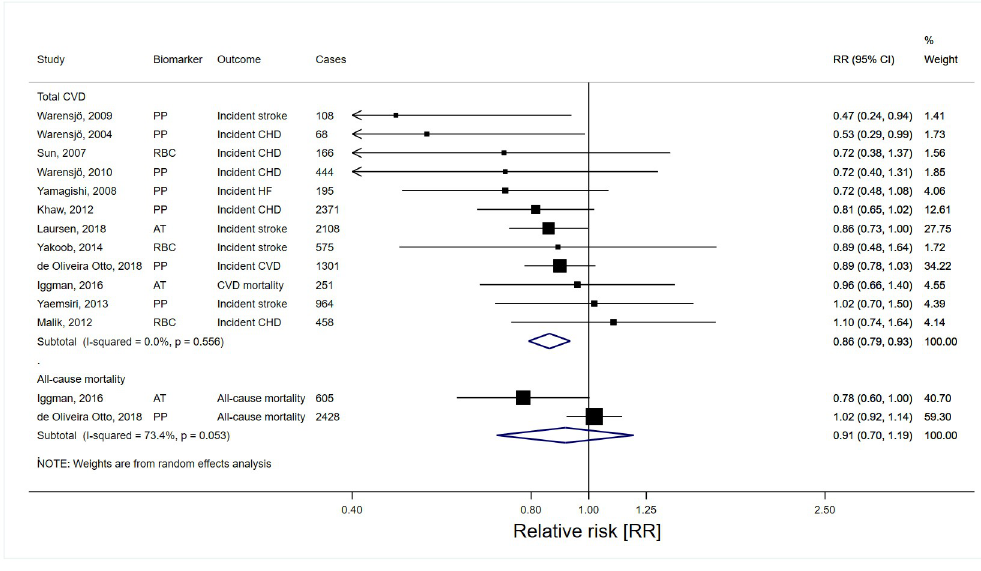
Fig 5. Risk estimates for CVD incidence and all-cause mortality in the top tertile of heptadecanoic acid (17:0) relative to the bottom tertile. AT, adipose tissue; CE, cholesterol ester; CHD, coronary heart disease; CI, confidence interval; CVD, cardiovascular disease; HF, heart failure; PP, plasma phospholipids; RBC, red blood cell (erythrocyte); RR, relative risk.